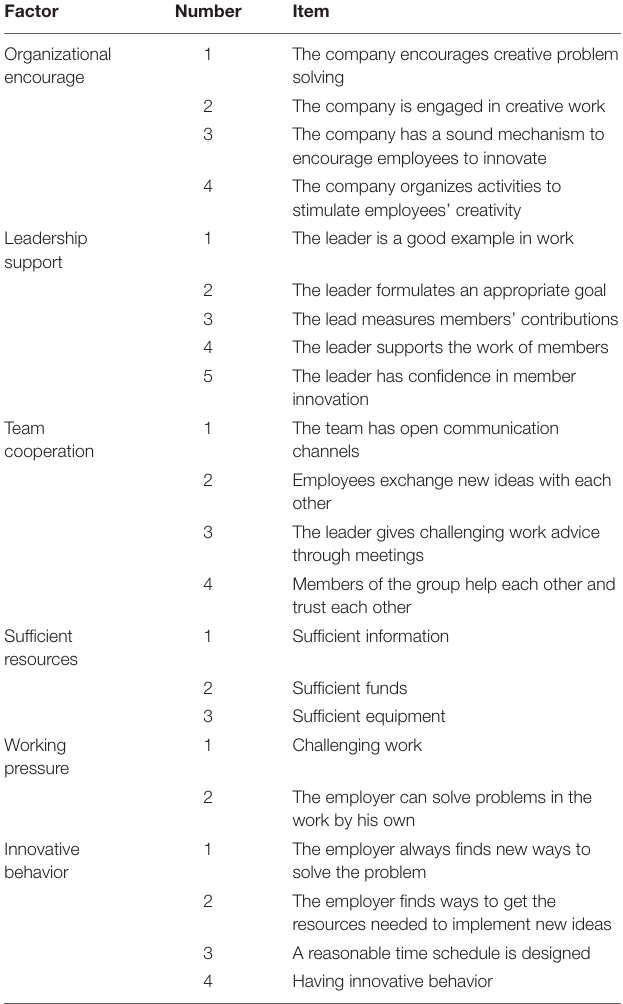
TABLE 3 | Details of the